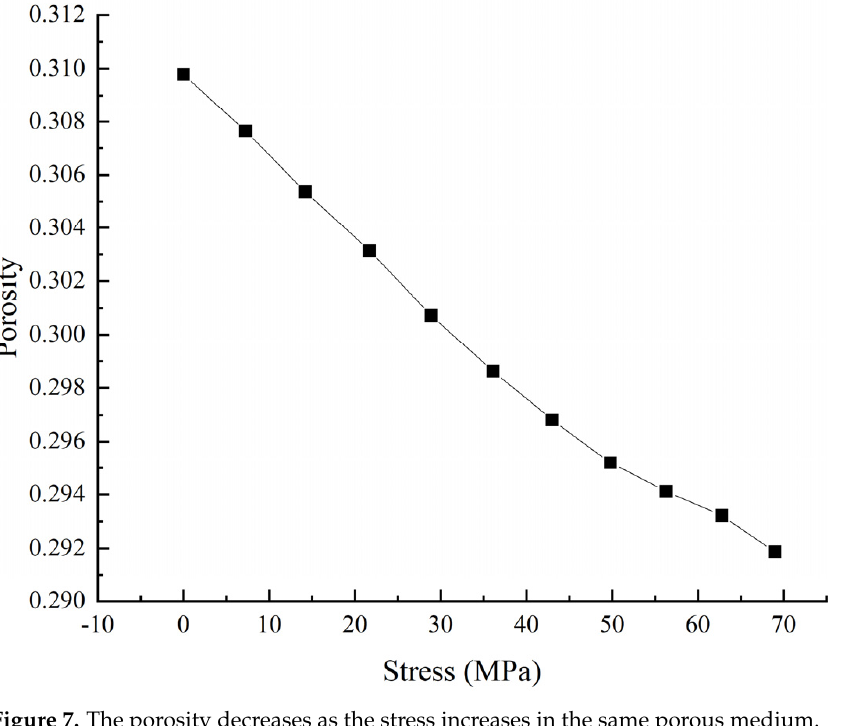
Geotechnics 2023 , 3 11 slows down in the middle and late stages due to the gradual cessation of the pressure in the x and y axis while the z axis pressure continued. This shows that stress and porosity have a good linear relationship.